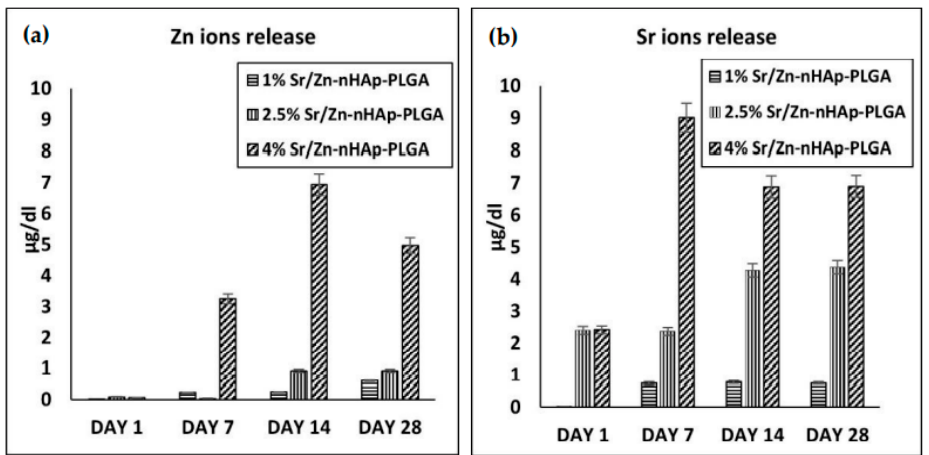
Figure 7. Ion release profile using ICP ‐ MS for 1% Zn/Sr ‐ nHAp ‐ PLGA, 2.5% Zn/Sr ‐ nHAp ‐ PLGA, and 4% Zn/Sr ‐ nHAp ‐ PLGA. ( a ) Zinc ions; ( b ) strontium ions.